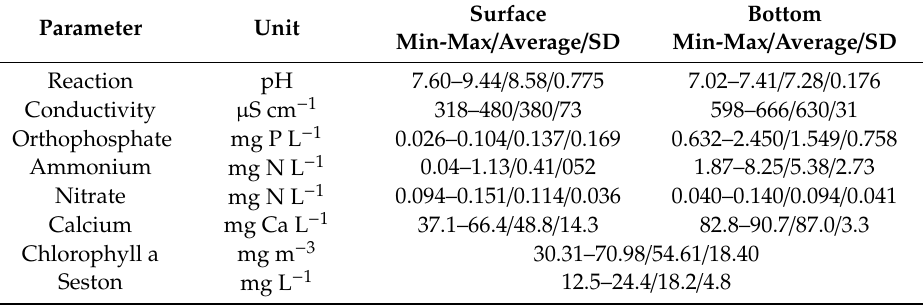
Table 6. Annual (2018) variability of the physicochemical parameters in the surface and bottom water layers of Miłkowskie